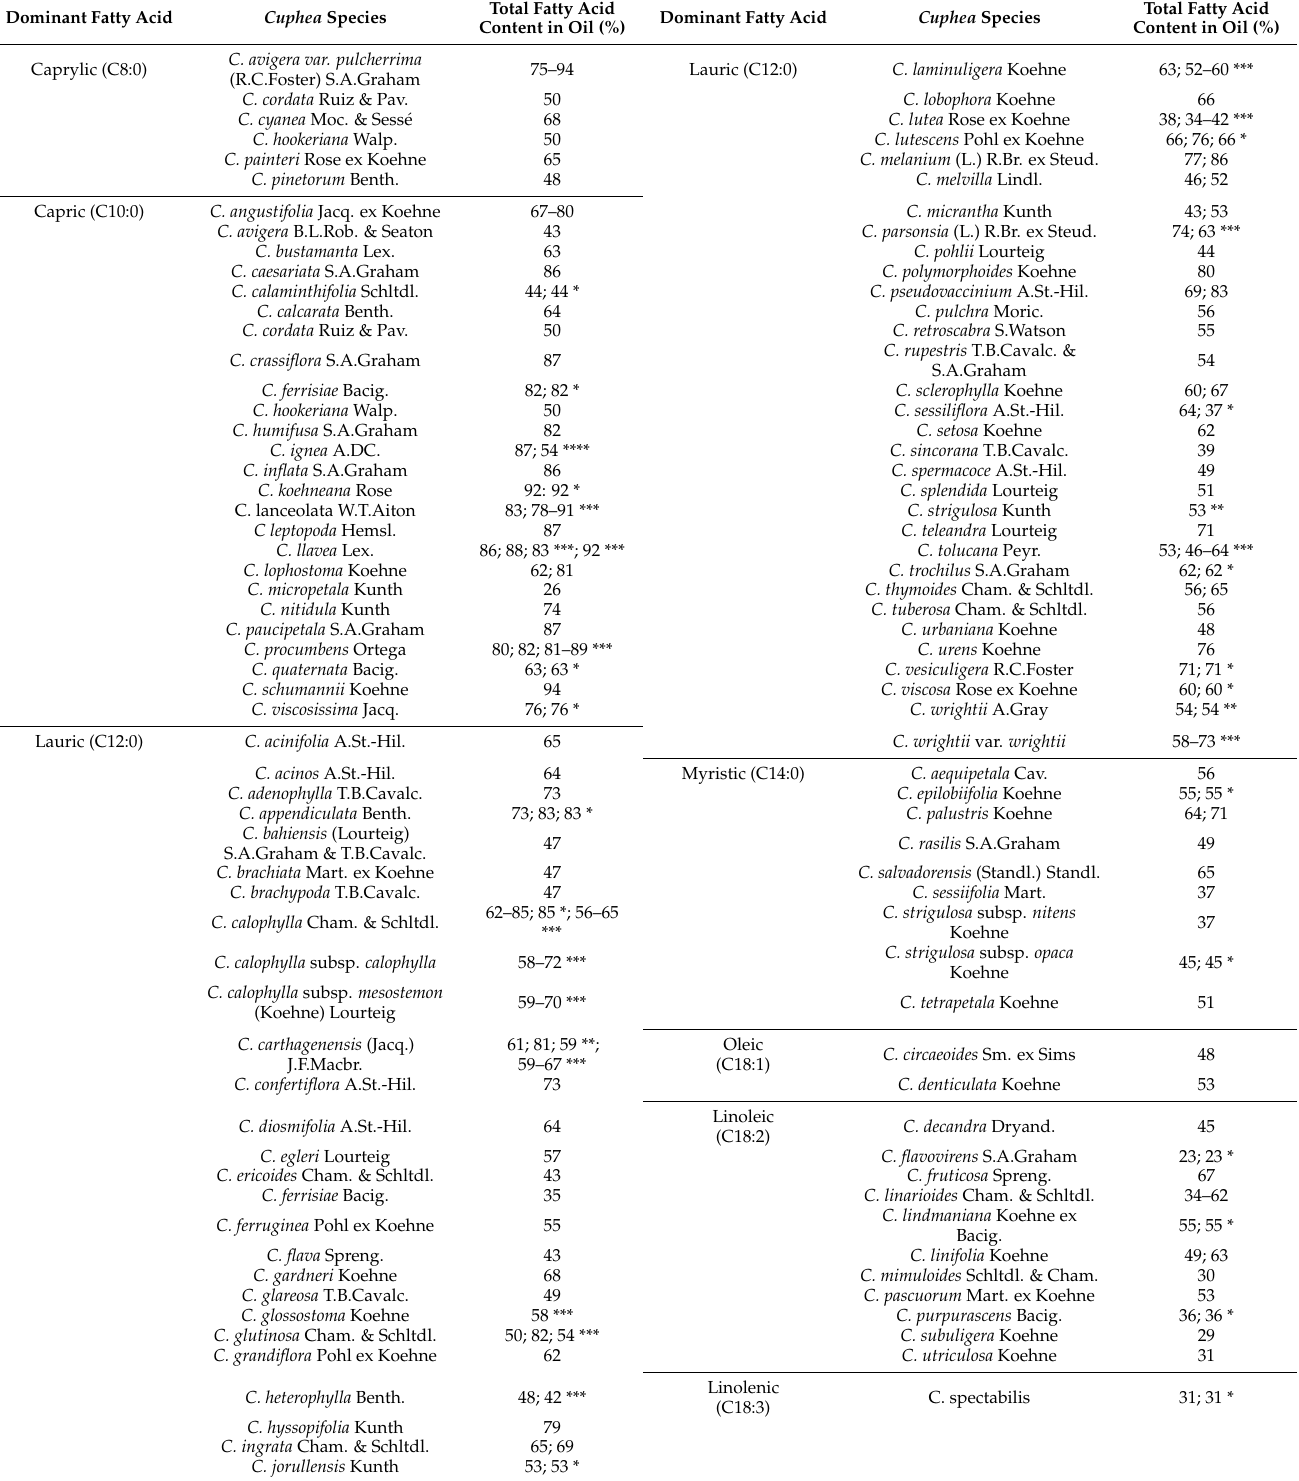
Table 1. Percentage of the predominant fatty acid content in oils of different Cuphea